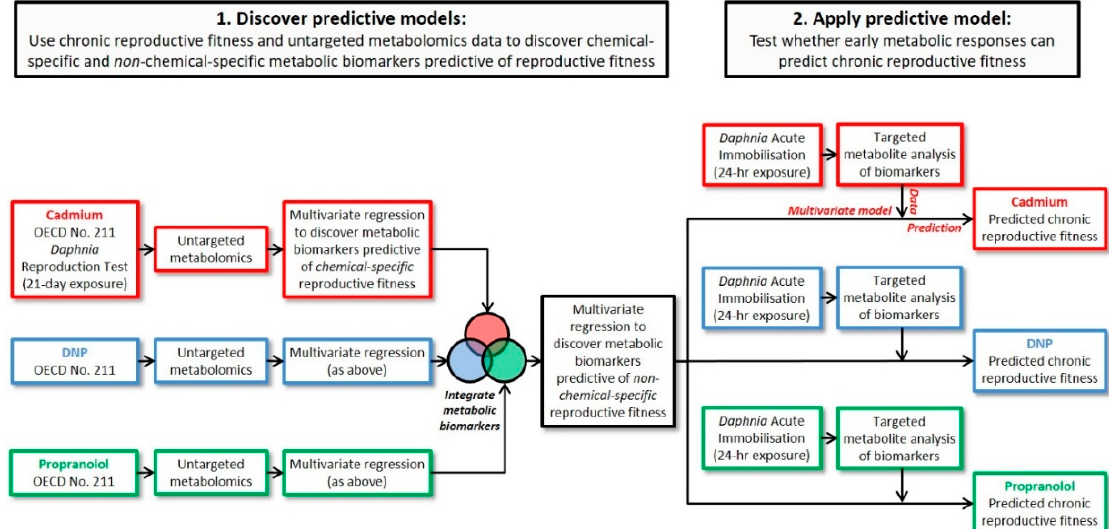
Figure 1. Overall workflow comprising of two Daphnia toxicity tests (chronic reproduction and acute immobilization), untargeted metabolomics, targeted metabolite analysis and multivariate modelling, ultimately leading to predictions of the chronic reproductive fitness of Daphnia from early-response metabolic biomarkers.